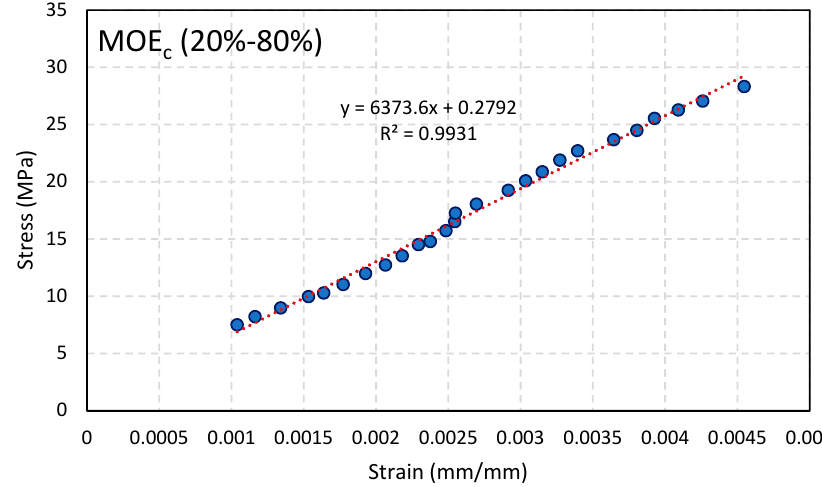
Figure 9. Determination of MOE c in the 20%–80% interval (specimen A1).